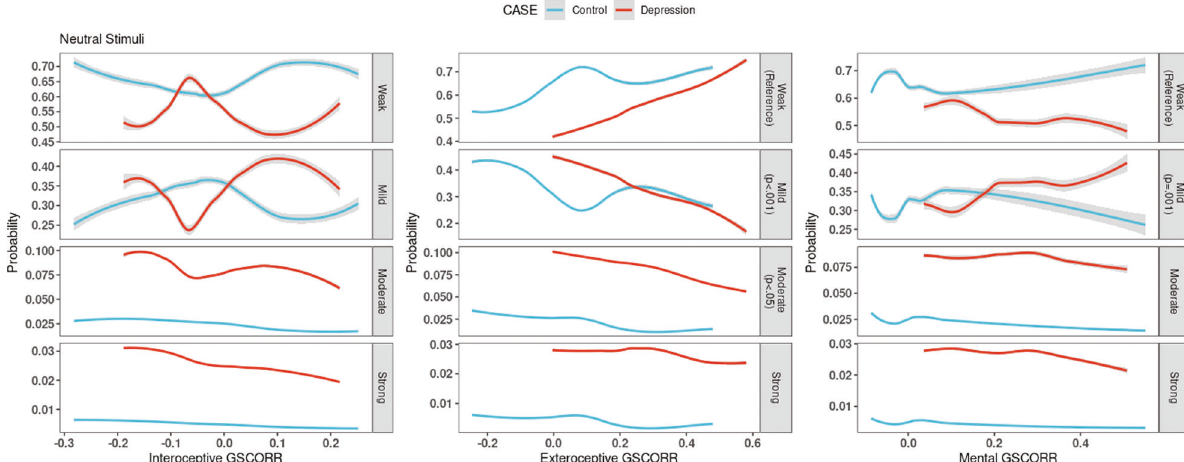
Fig. 6 Probability of emotional response according to GSCORR while attending the neutral stimuli. The x -axis shows GSCORR value the while y -axis shows probability of emotional response relative to the reference. Signi fi cant or marginal results are highlighted in gray tabs with respective p values. Blue color represents healthy controls while red represents MDD group. Interoceptive self GSCORR has no signi fi cant relation with emotional response ( fi rst column). Increase in exteroceptive self GSCORR increases the chance of mild emotional response, whereas GSCORR decreases weak emotional response (second column). Increase in mental self GSCORR decreases mild emotional response and increases weak emotional response in the control group (third column). Increase in mental self GSCORR increases the chance of mild emotional response and decreases weak emotional response in the MDD group.